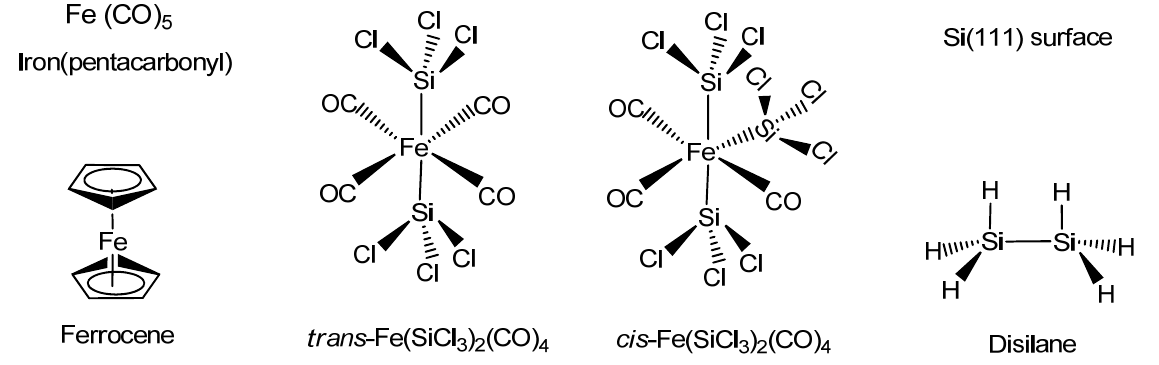
Figure 11. Structures of the typical organometallics used in the formation of FeSi, such as Fe(CO) (Iron pentacarbonyl), Fe(C 5